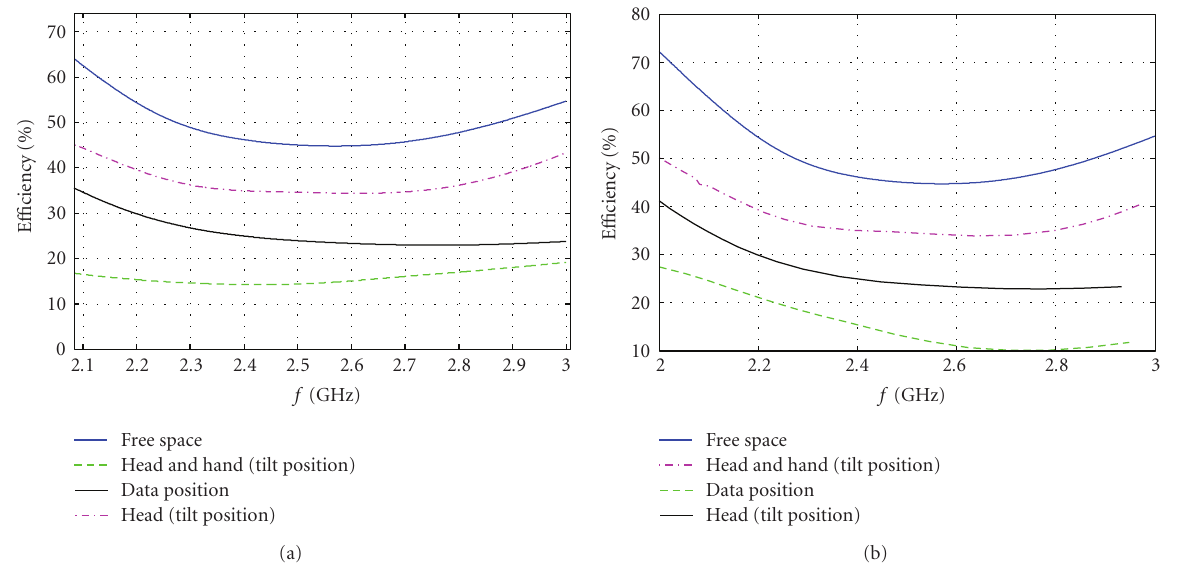
Figure 5: E ffi ciencies for both antennas in MIMO design, (a) antenna 1, and (b) antenna